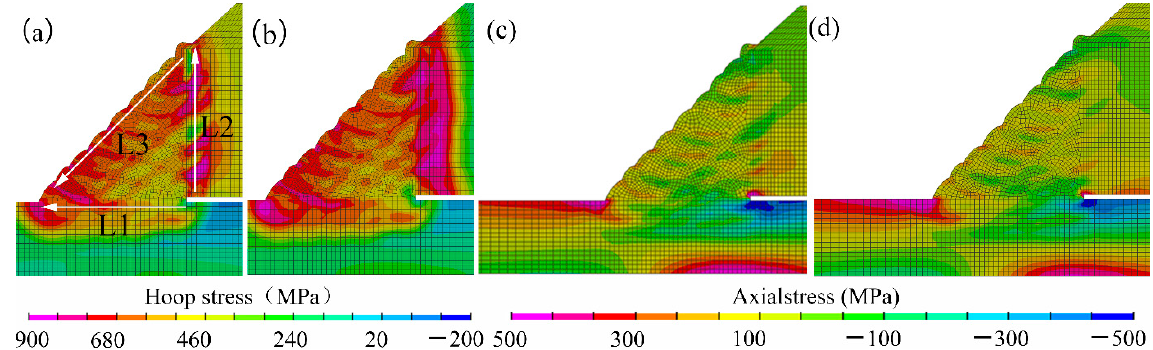
Figure 20. Effect of sleeve pipe material on residual stress distribution: ( a ) Q345B, ( b ) X80, ( c ) Q345B, ( d )X80.